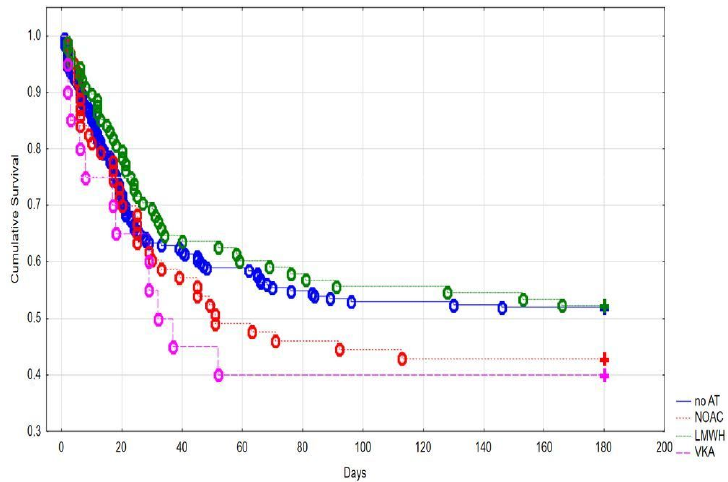
Figure 3. Kaplan–Meier curve showing cumulative survival stratified for patients with different anticoagulation management protocols.